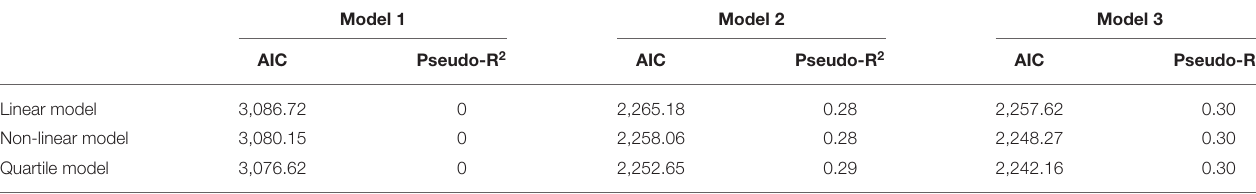
TABLE 3 | AIC values and pseudo R 2 in different